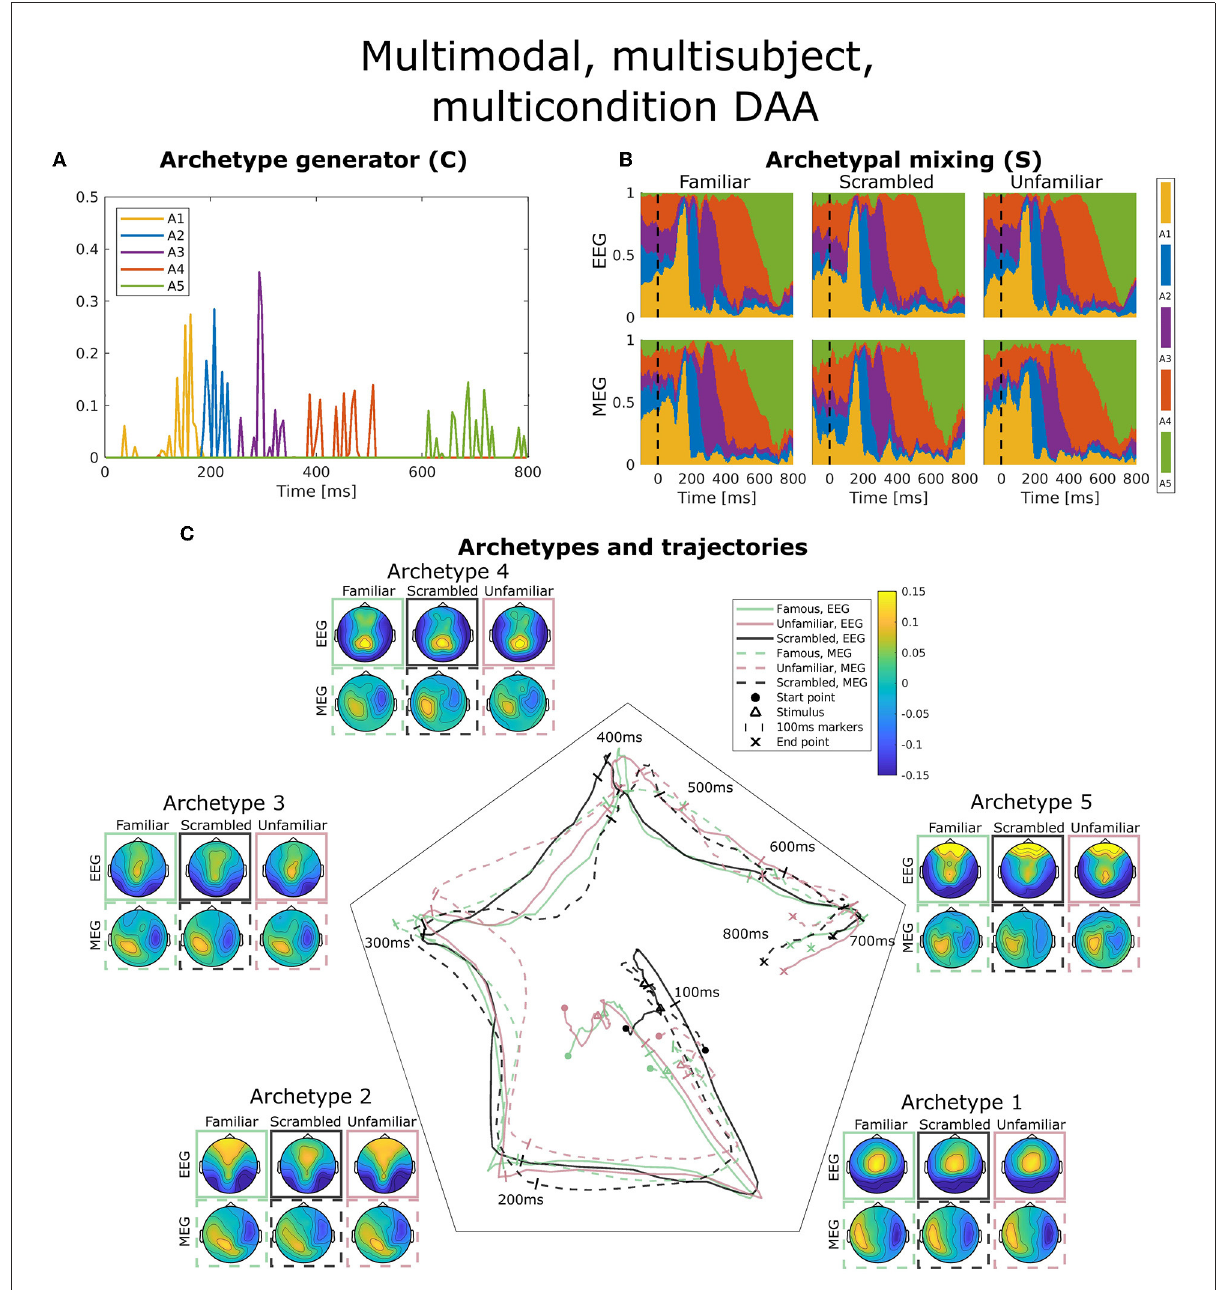
FIGURE5 Visualization of the best obtained fit for multimodal, multisubject, multicondition DAA with K condition-shared archetype generator matrix C with information on the specific samples from which archetypes are generated. (B) The archetypal mixing matrix S averaged across subjects showing how samples are probabilistically allocated to archetypes. The mixing matrix has been smoothed with a rectangular window of size 3 samples. (C) Archetype trajectory averaged across subjects based on the mixing matrix S smoothed with a rectangular window of 10 samples as well as average archetype topographical maps.